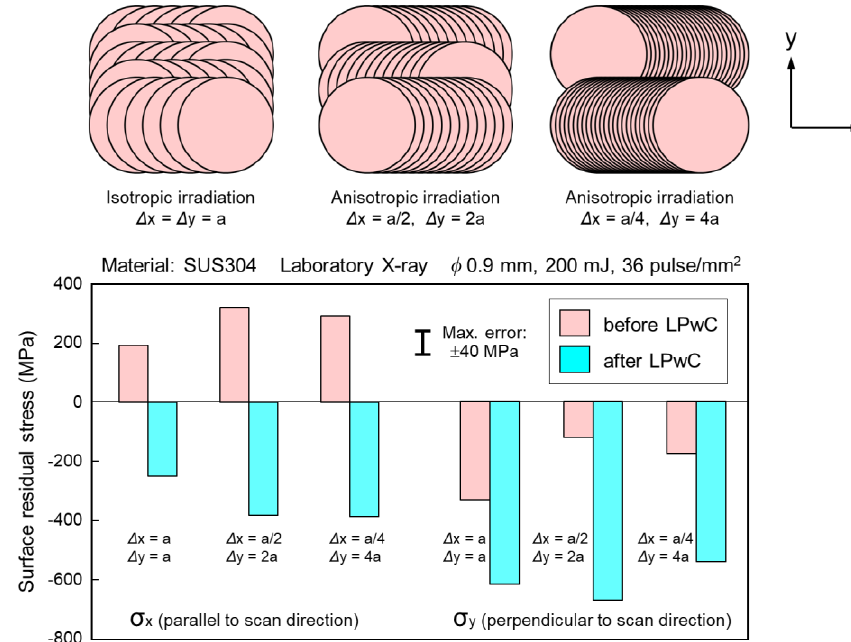
Figure 8. Surface RSs before and after area isotropic and anisotropic irradiation.